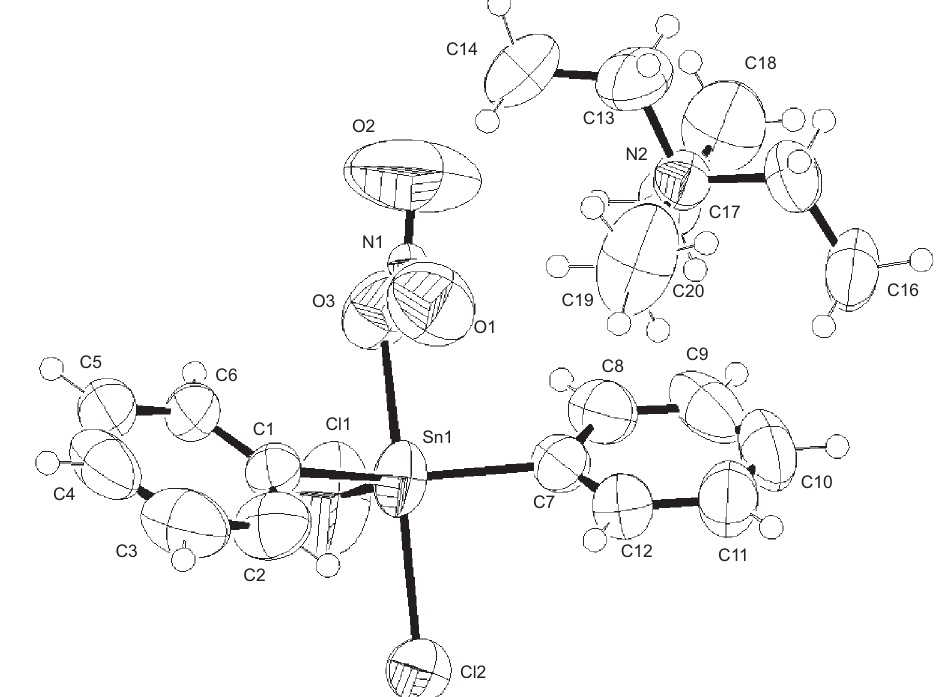
Figure 1 An ORTEP view of the asymmetric unit of the title compound, showing the atom numbering scheme. Displacement ellipsoids are plotted at the 50% probability